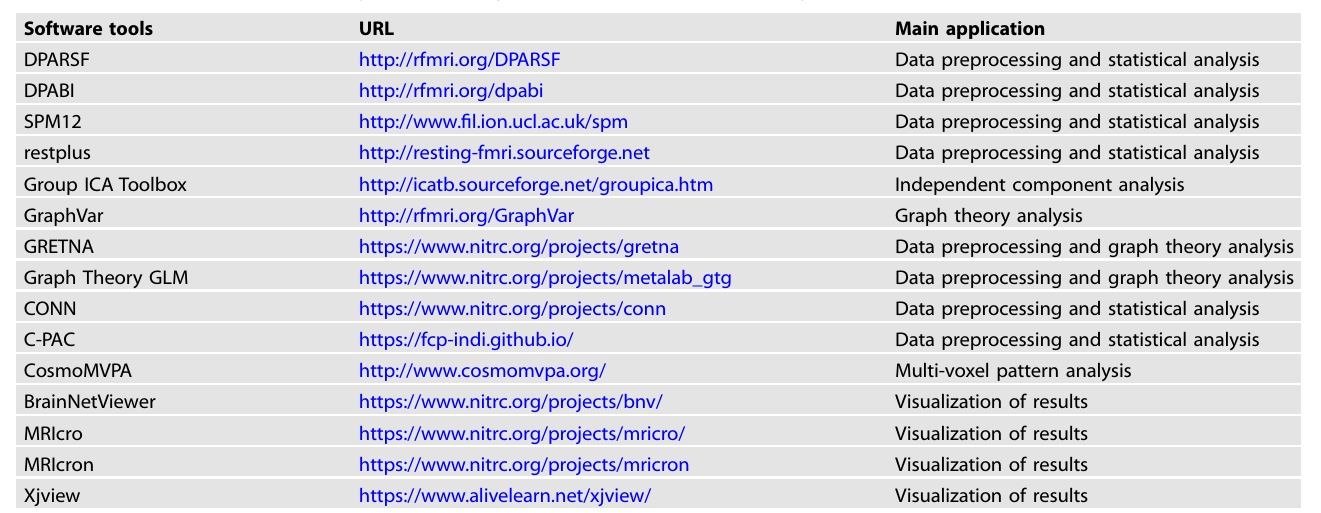
Fig. 1 The brief work fl ow of fMRI-based brain functional connectome. FC functional connectivity, BOLD blood oxygen level dependent. Table 1. Software and tools commonly used in resting-state functional connectome